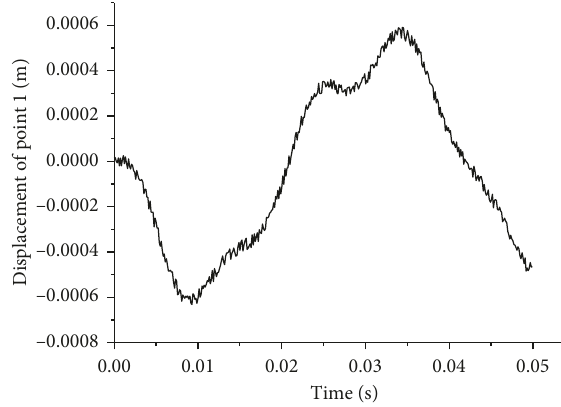
Figure 3: Displacement response of point 1 by F